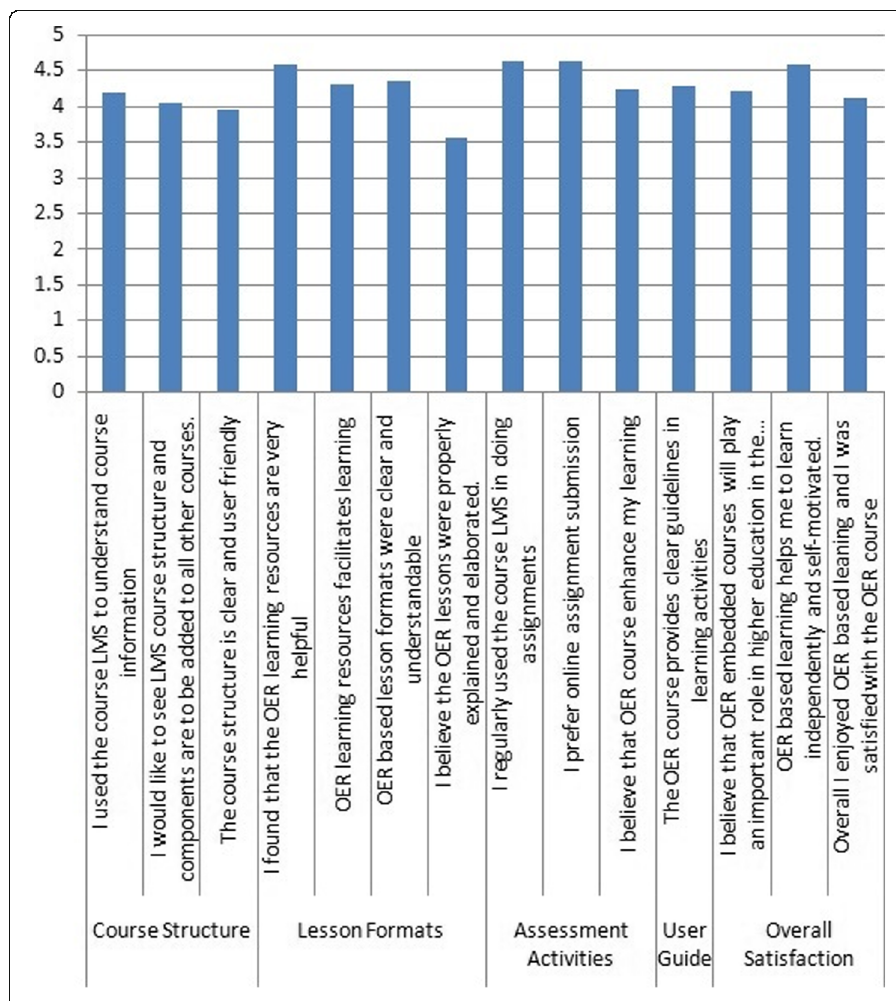
Fig. 4 Average mean values of the research